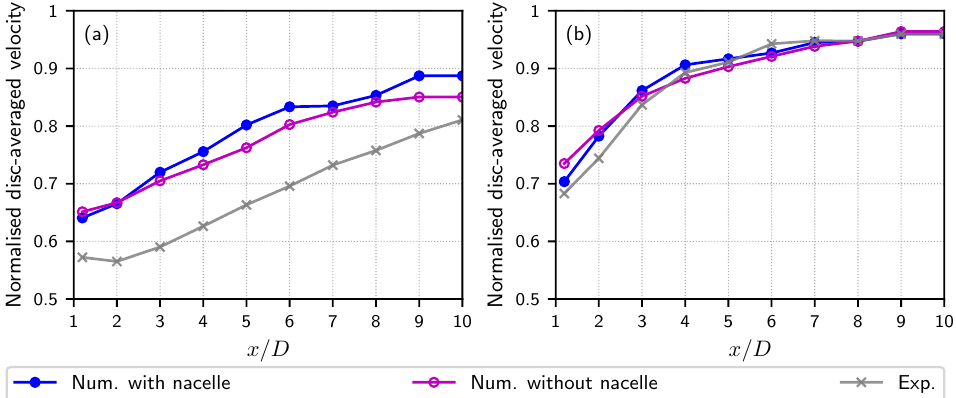
Figure 6. Comparison of the experimental and numerical disc-averaged velocities (TSR = 3.67, λ = 4.5 m, σ ( λ ) = 0% and R f = 1). ( a ) I ∞ = 1.5%. ( b ) I ∞ = 15%.